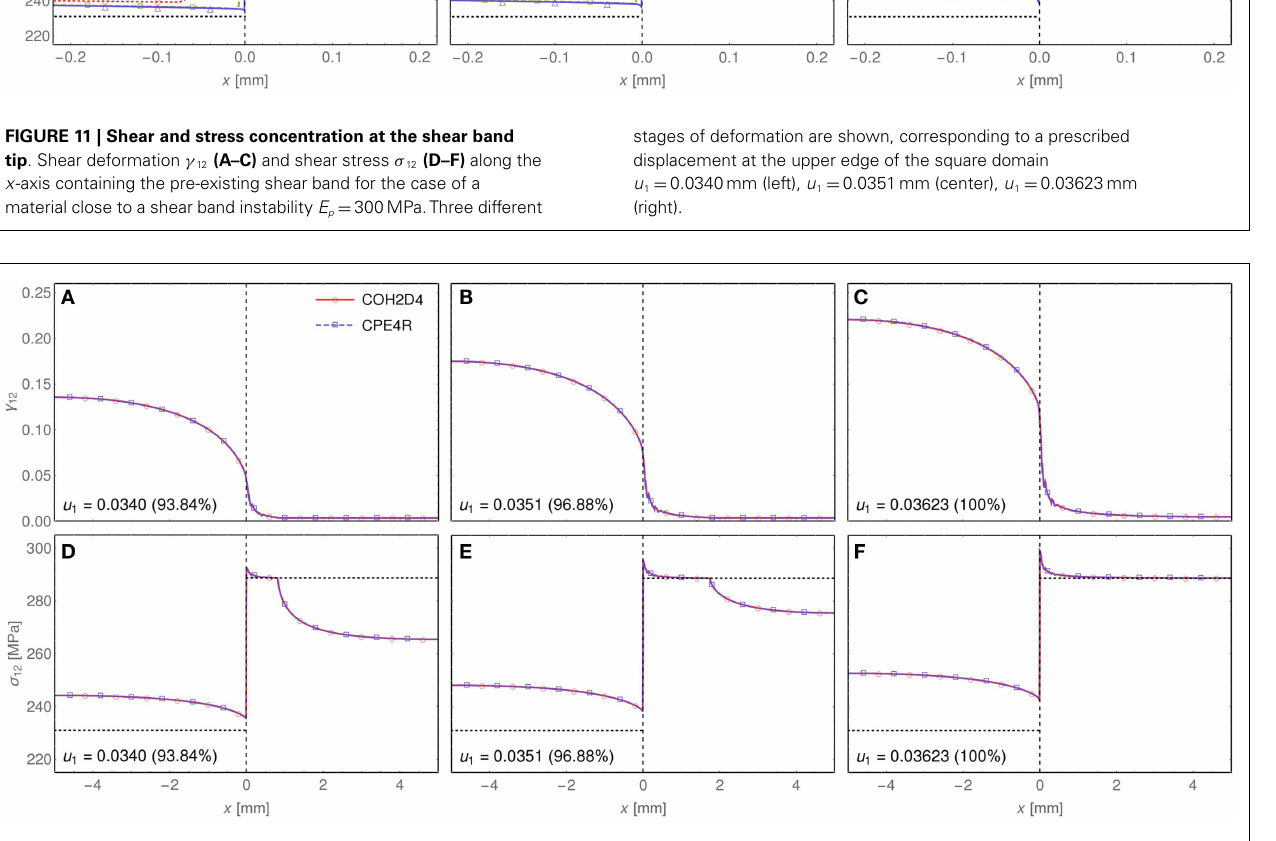
pre-existing shear band for the case of a material close to a shear band instability E p = 300MPa.Three different stages of deformation are shown, corresponding to a prescribed displacement at the upper edge of the square domain u 1 = 0.0340mm (left), u 1 = 0.0351mm (center), u 1 = 0.03623mm